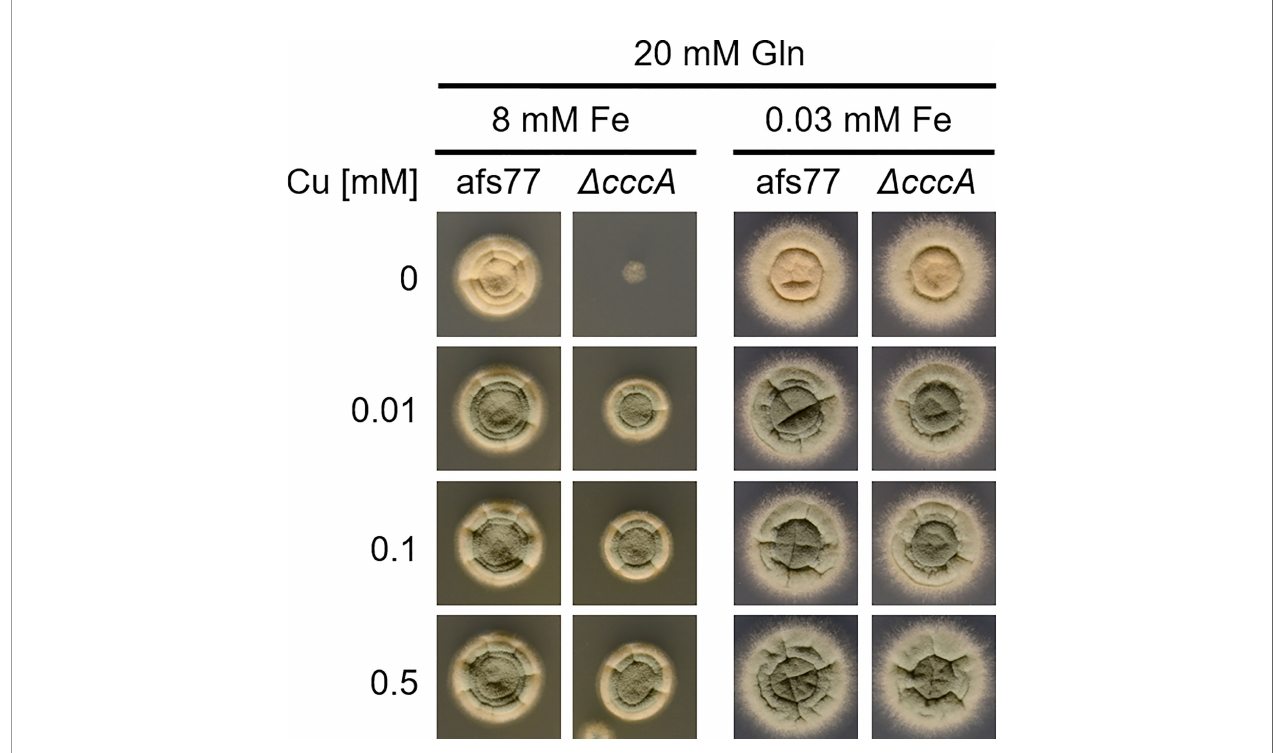
FIGURE 8 | Cu availability impacts Fe resistance. A. fumigatus conidia were point-inoculated on AMM plates with 20 mM Gln as nitrogen source containing different concentrations of Cu and Fe. Gln was used here as nitrogen source as this high Fe amount precipitates with ammonium as nitrogen source. Afs77 is the genetic background of the D cccA mutant strain (Gsaller et al.,